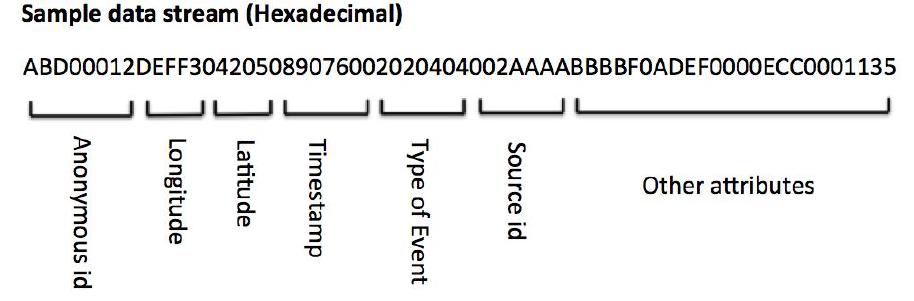
Figure 2. A sample mobile CDR example (hexadecimal format).